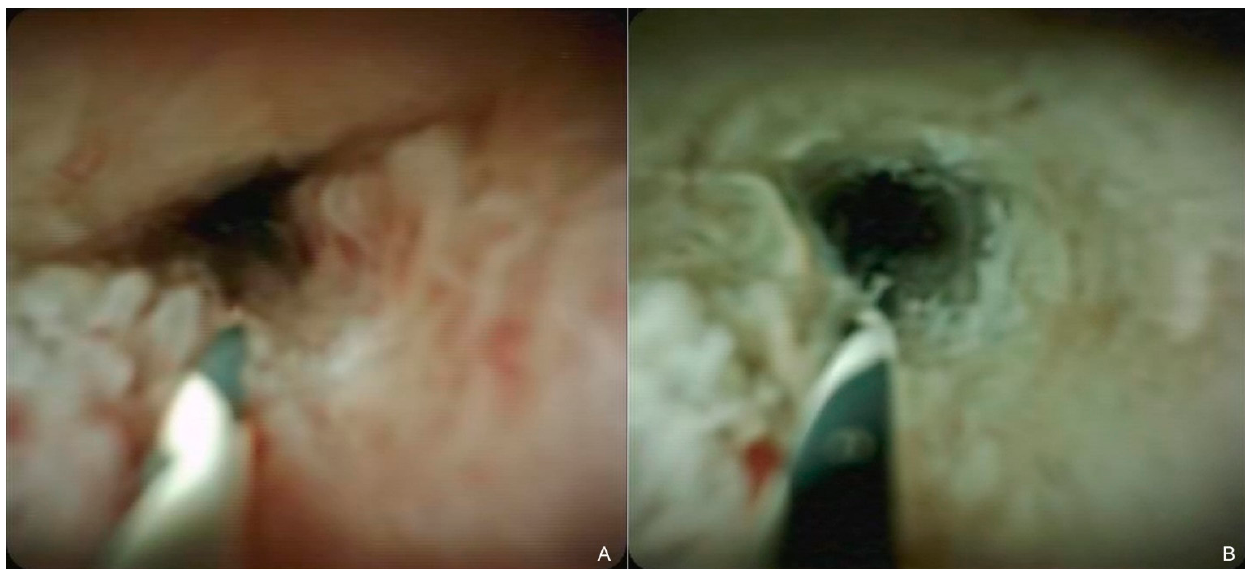
Figure 1. Cholangioscopic findings of the biliary stricture before ( A ) and after ( B ) radiofrequency ablation. The tumor showed coagulative necrosis, and the stricture improved after the ablation procedure.